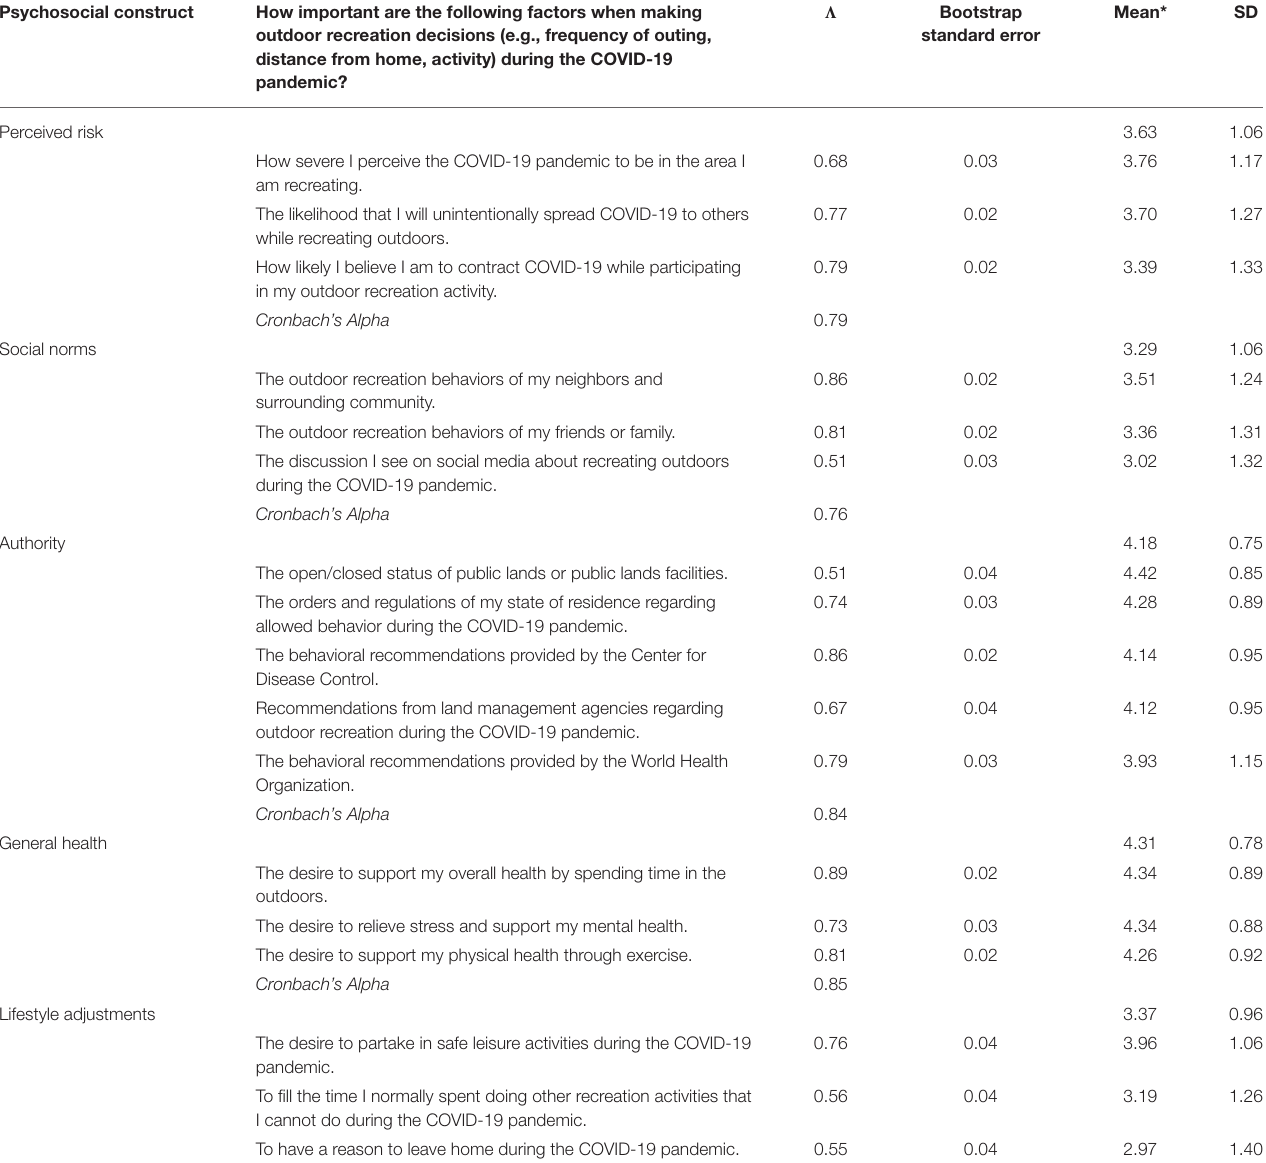
TABLE 3 | Scale development indices and single-item/scale